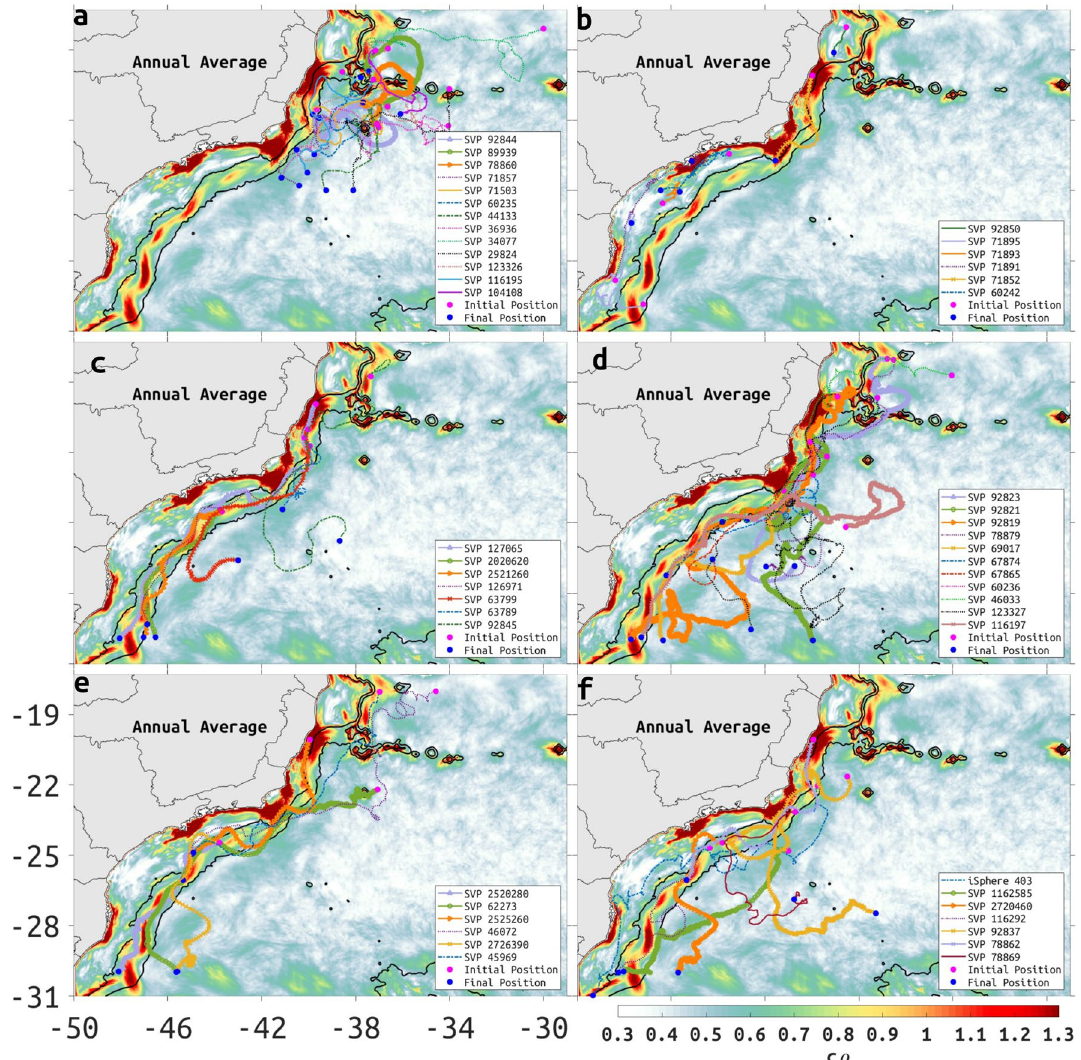
Figure 7. Selected trajectories of satellite-tracked SVP drifters, interpolated at 6 h intervals, distributed by NOAA’S Global Drifter Program, and of iSPHERE, distributed by Prooceano with consent of PetroRio, superposed to the annual-mean c ρ . ( a ) Drifters trapped in eddies and meanders near the Vitória-Trindade Seamount Chain and Almirante Saldanha seamount; ( b ) drifters confined in weakly attracting regions or inshore of the 200-m isobath; ( c ) drifters traveled inshore of the BC core, between the 200- and 2000-m isobaths; ( d ) drifters moved offshore of the 2000-m isobath; ( e ) drifters with onshore-offshore oscillatory motion; ( f ) drifters with a large onshore-offshore displacement. Depth contours of 200- and 2000-m are represented by thin black lines. The identification number of each Surface Velocity Drifter is shown in the insert of each frame. Created with Matlab R2018B (www.mathw